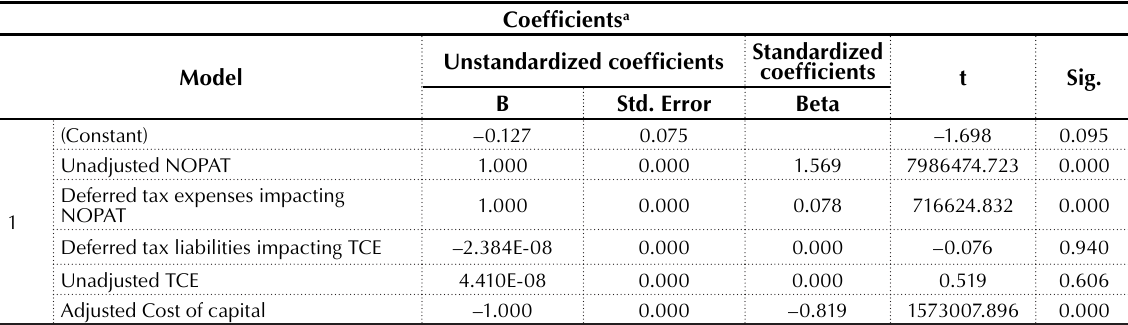
Table 6. Coefficient test for individual